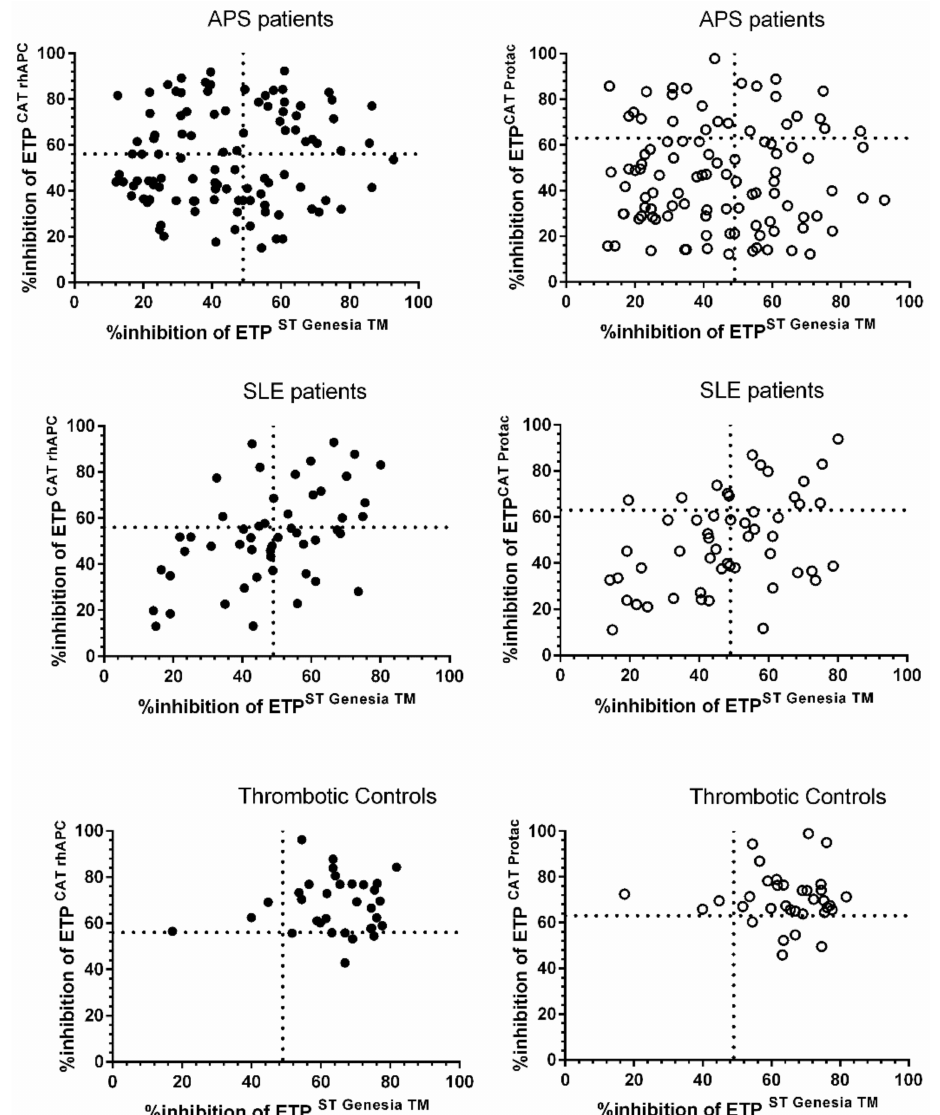
Figure 2. Agreement in APCr between the ST-Genesia ® in the presence of TM and the CAT analyser with rhAPC ( left panel) and Protac ® ( right panel) in APS, SLE patients and thrombotic controls. Vertical broken line represents the cut off value for APCr with the ST-Genesia ® (49%), and the horizontal dotted line in the left panel represents the APCr cut off value of 56% for the CAT with rhAPC, and in the right panel, the APCR cut off value of 63% for the CAT with Protac ® . All cut-offs were defined as values below the nintey-ninth centile of